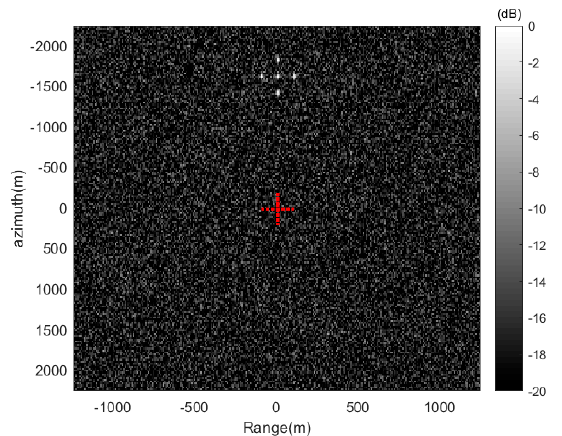
Figure 8. The corresponding GRFT response for target detection.